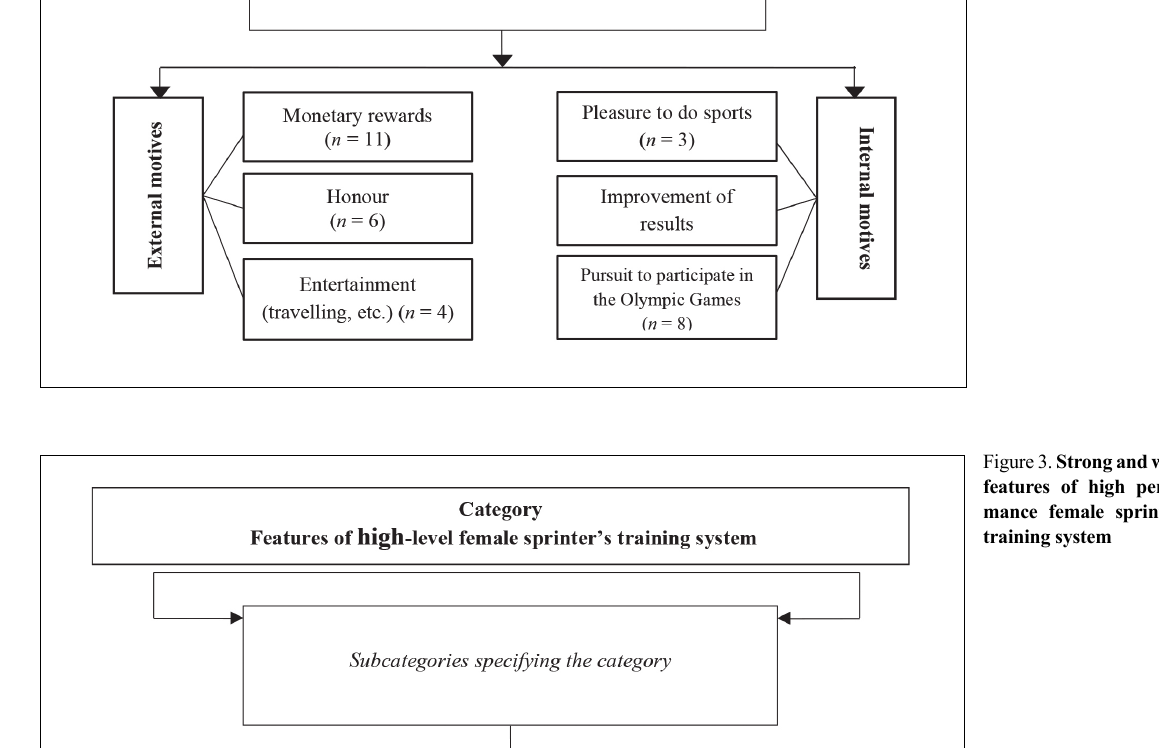
Figure 2. Motives influ- encing the training of high performance fe- male